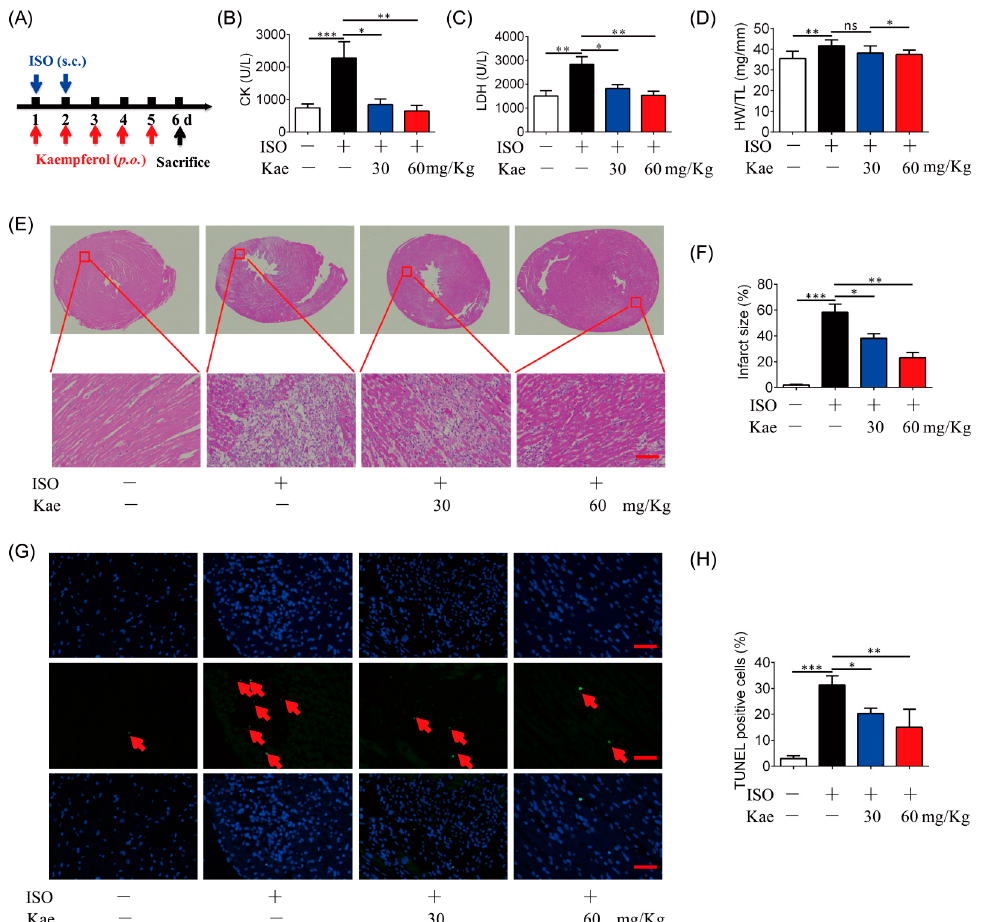
Figure 5. Kae protects the heart from ISO-induced myocardial damage in rats. ( A ) The myocardial damage in rats was established with isoprenaline (ISO) for 2 days, and Kae was orally administrated (30, 60 mg/kg, 5d). ( B ) The level of CK in the blood (n = 6). ( C ) The leakage of LDH in the blood (n = 6). ( D ) The ratio of heart weight to tibia length (HW/TL) (n = 6). ( E ) Representative HE-stained heart sections, the lower panel are enlarged from the red boxex in the upper panel (n = 6, scale bar, 50 μ m). ( F ) Quantitative analysis of infarct size. ( G ) Apoptosis detection using TUNEL staining assay (scale bar, 50 μ m). The red arrows indicate TUNEL positive cells. ( H ) Quantification of TUNEL positive cells (n = 6). * p < 0.05, ** p < 0.01, *** p < 0.001 and ns, statistically not significant.